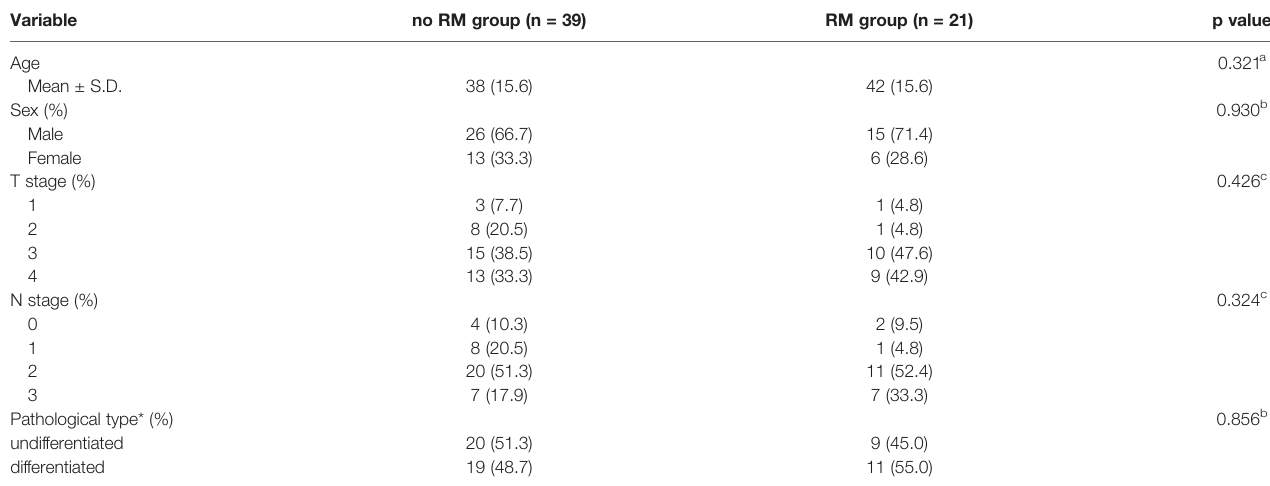
TABLE 1 | Clinical characteristics of the NPC patients (n =